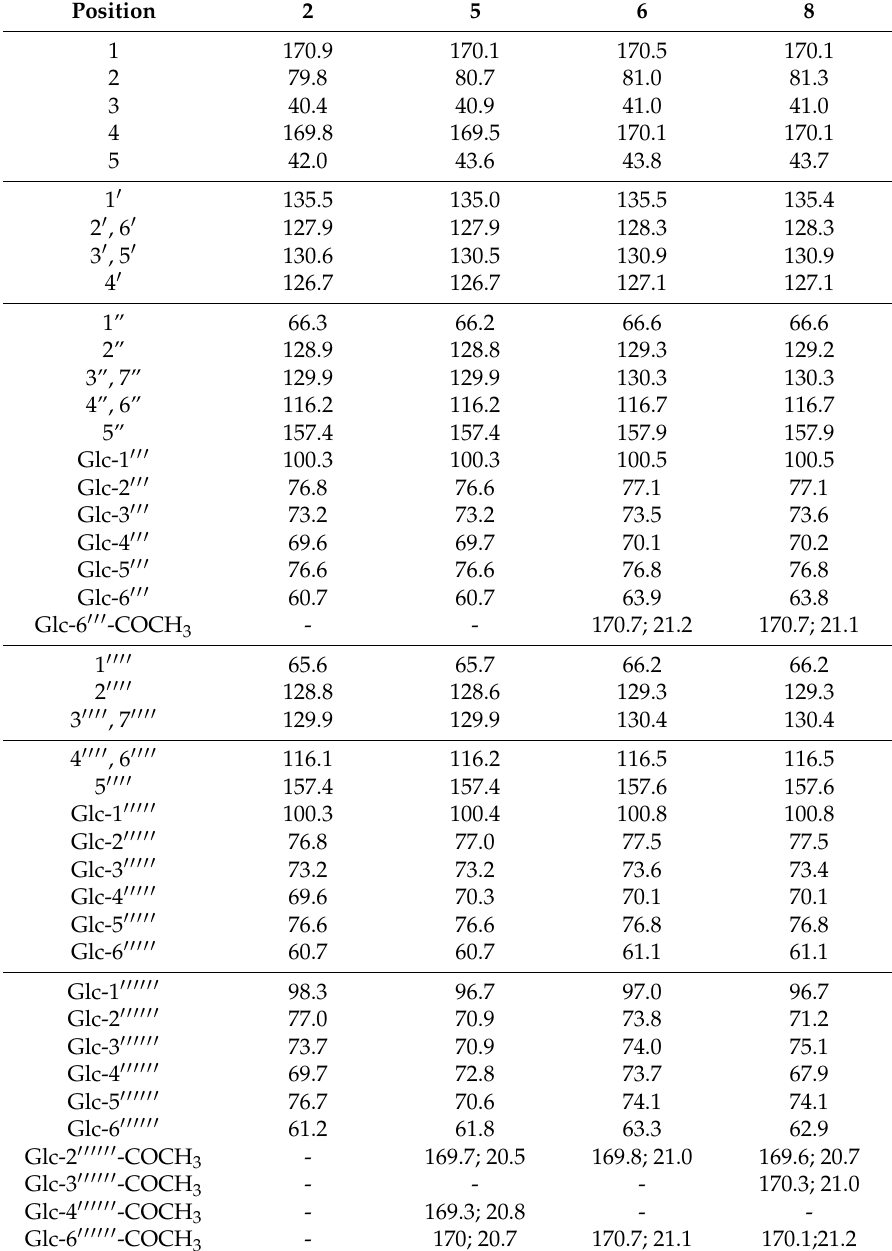
Table 2. 13 C NMR data of four new compounds (175MHz,